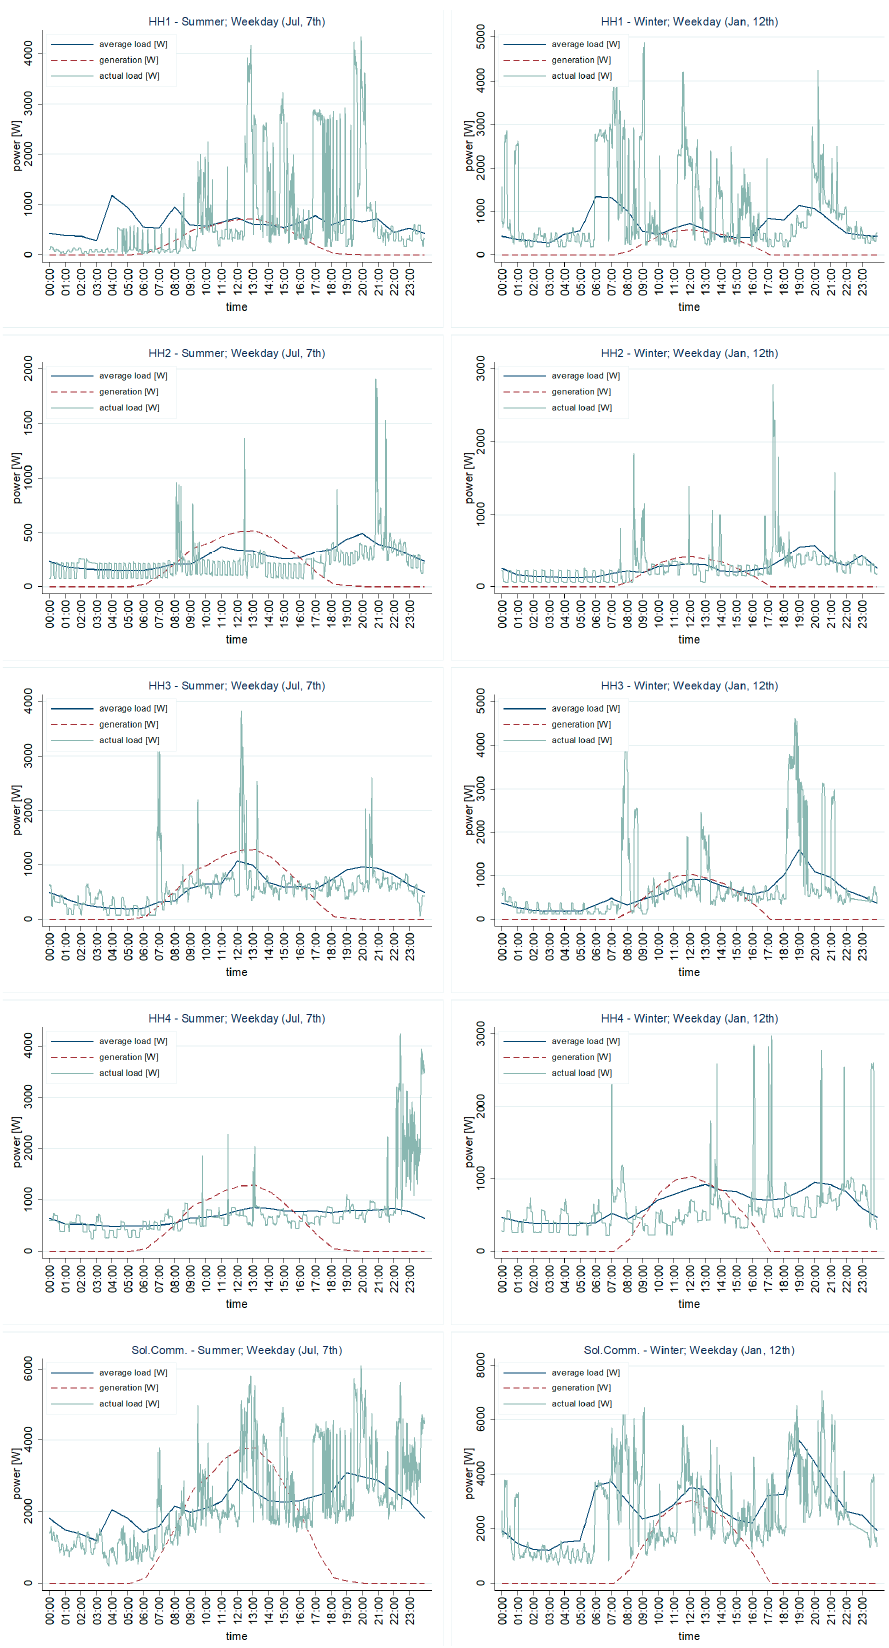
Figure 1. Load and generation curves for two arbitrarily picked working days, one in winter and one in summer. Dark blue line: daily demand curve averaged over the whole month; light grey: